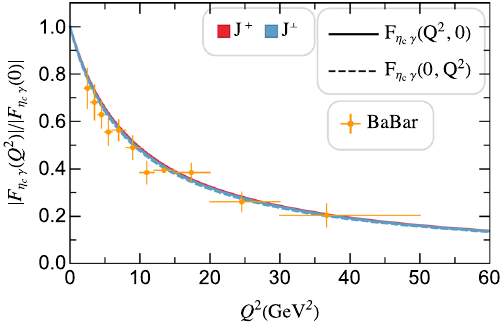
Fig. 16 The normalized transition form factor of η c calculated accord- ing to Eqs. (74) and (75), in red and blue, respectively. We use the η c LFWF in Eq. (50) (see values of basis coefficient in Table 4). The solid line is obtained by taking the limit of Q 2 ( Q 2 , 0 ) ], and the dashed by taking Q 2 F η c γ ( 0 , Q 2 ) ]. The BaBar experimental data is taken from Ref. F η c γ